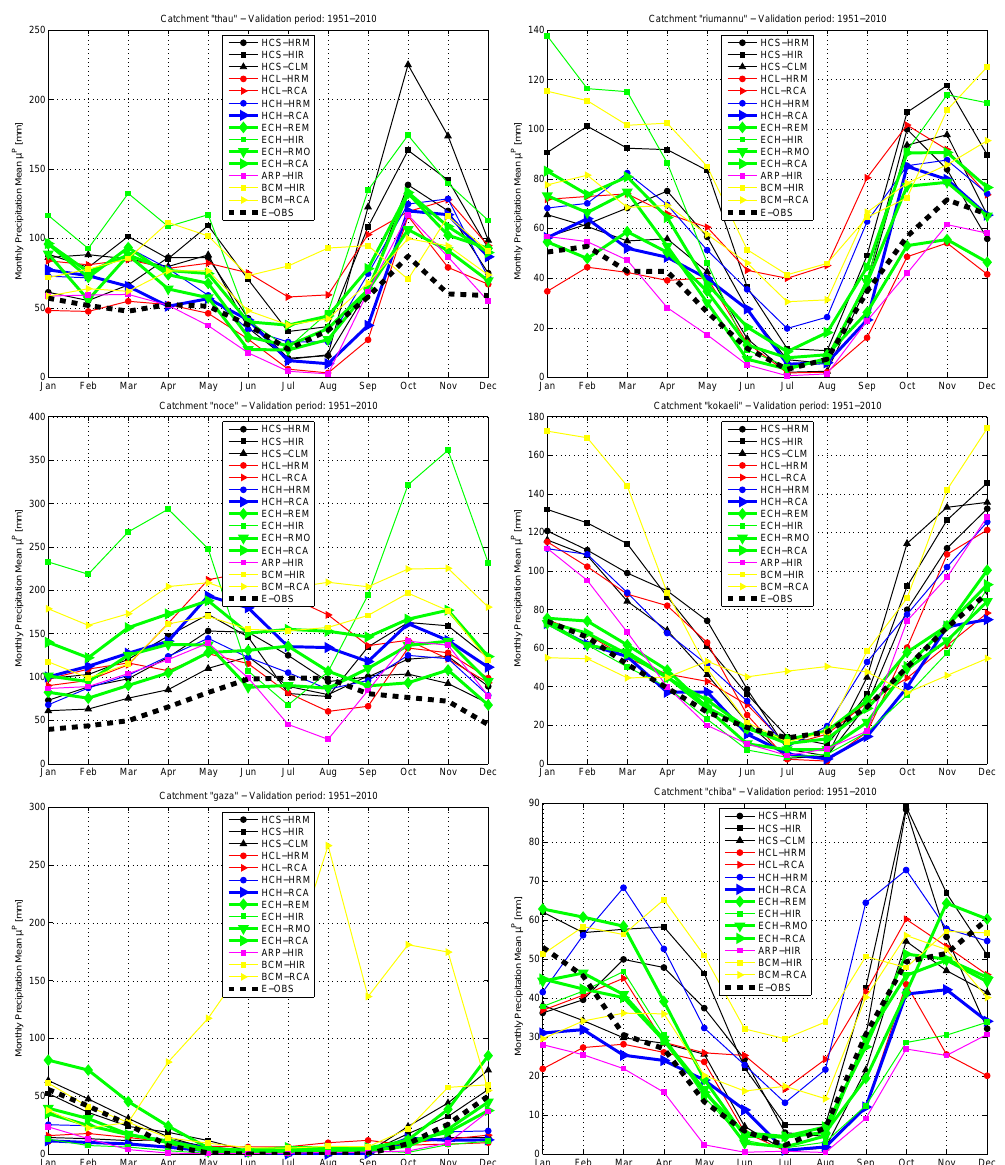
Fig. 3. Mean monthly precipitation (mm) over the 60yr verification period (1951–2100) for the 14 ENSEMBLES models and E-OBS. Each subplot displays areal averages over a 4 × 4 grid-point stencil centered on each catchment.